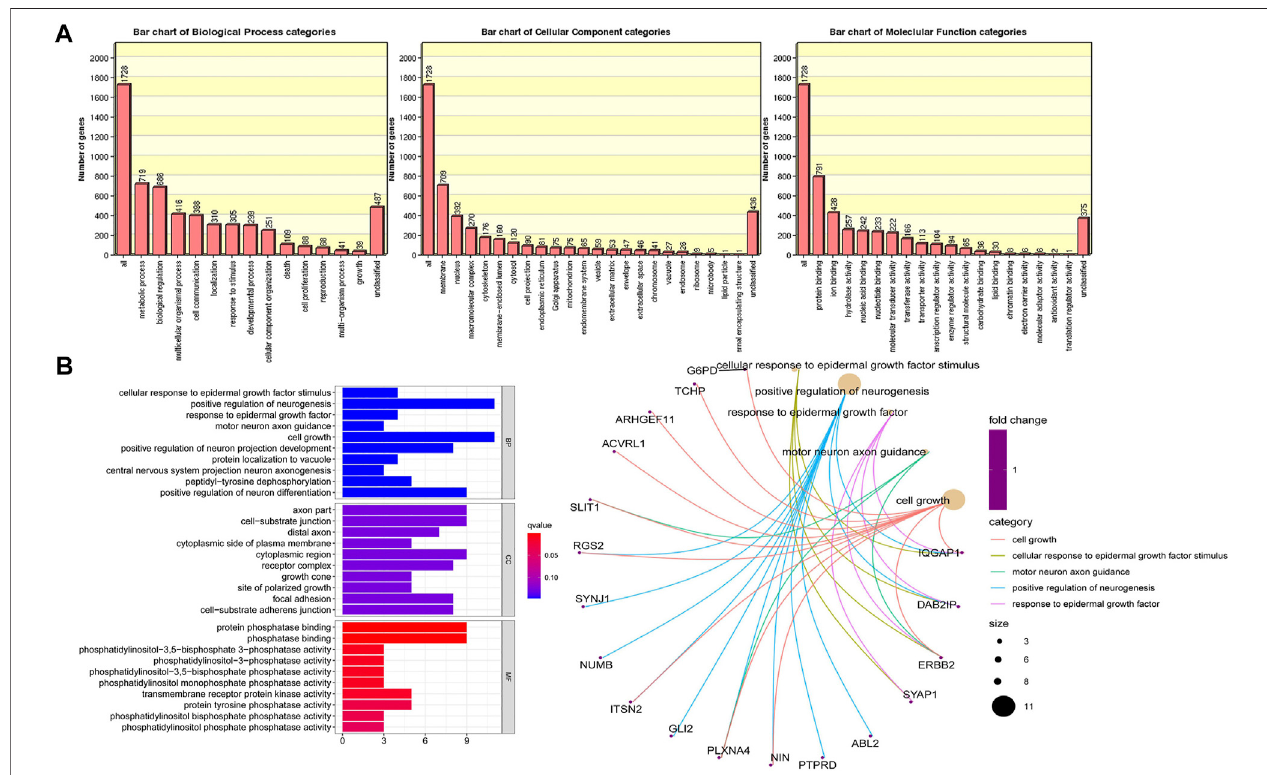
FIGURE2| Thedifferentialsinglenucleotidepolymorphisms(SNPs)oftargetgeneswerefoundtobefunctionallyenrichedbyageneontologyenrichmentanalysis, which mainly included three aspects: biological processes (BPs), molecular functions (MFs) and cellular components (CCs). (A) Functional enrichment analysis of 1828 SNP variant genes ( p < 0.05); (B) Functional enrichment analysis of 391 SNP variant genes ( p <